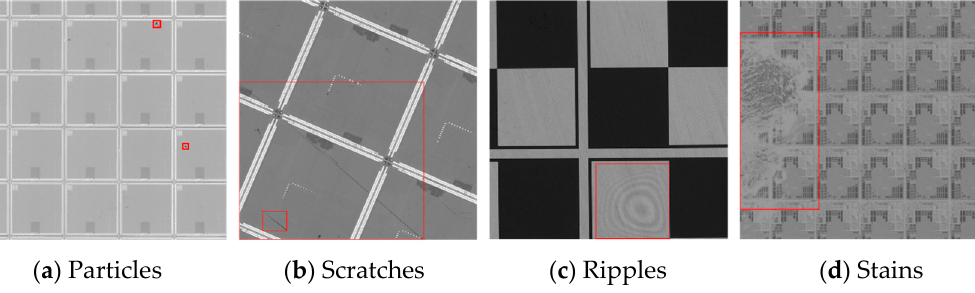
Figure 1. Classification of wafer surface defects.